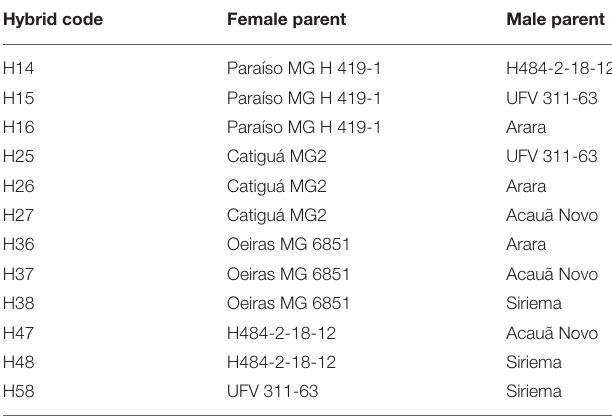
TABLE 3 | Crossings performed according to the circulating diallel